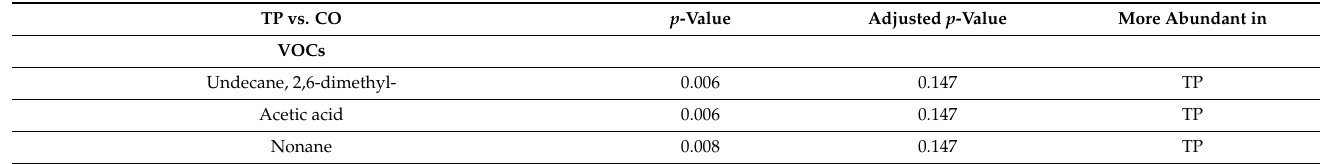
Table 2. Comparison of volatile organic compound (VOC) abundance from the colonic contents of horses positive for Anoplocephala perfoliata and non-infected controls. TP vs.